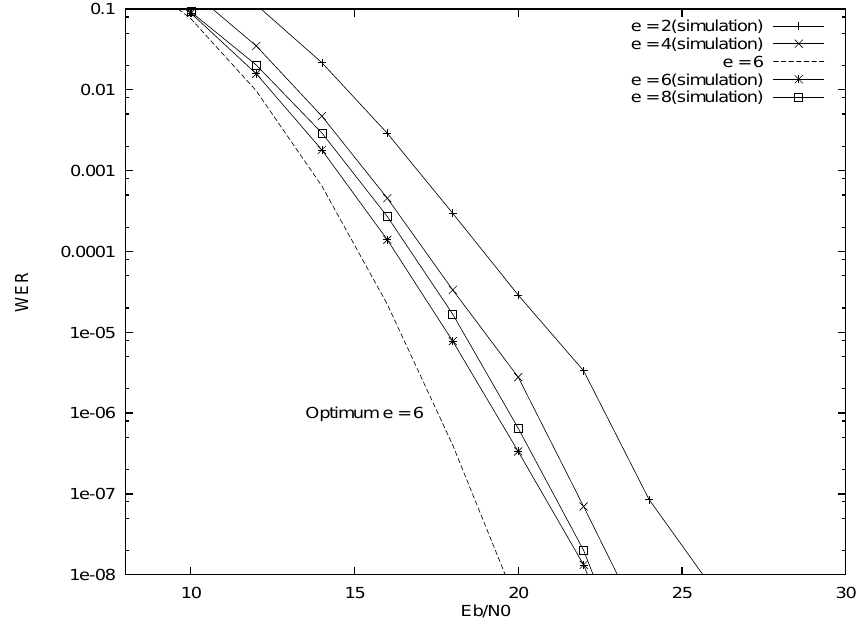
Figure 5. WER vs. E b / N 0 for truncation only with ordering.